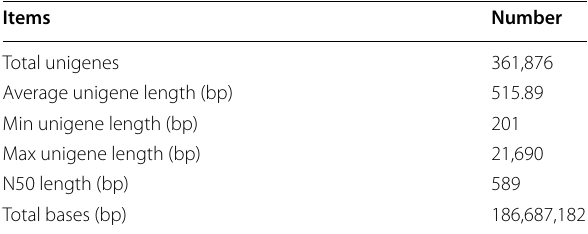
Table 2 Overview of the sequencing and assembly